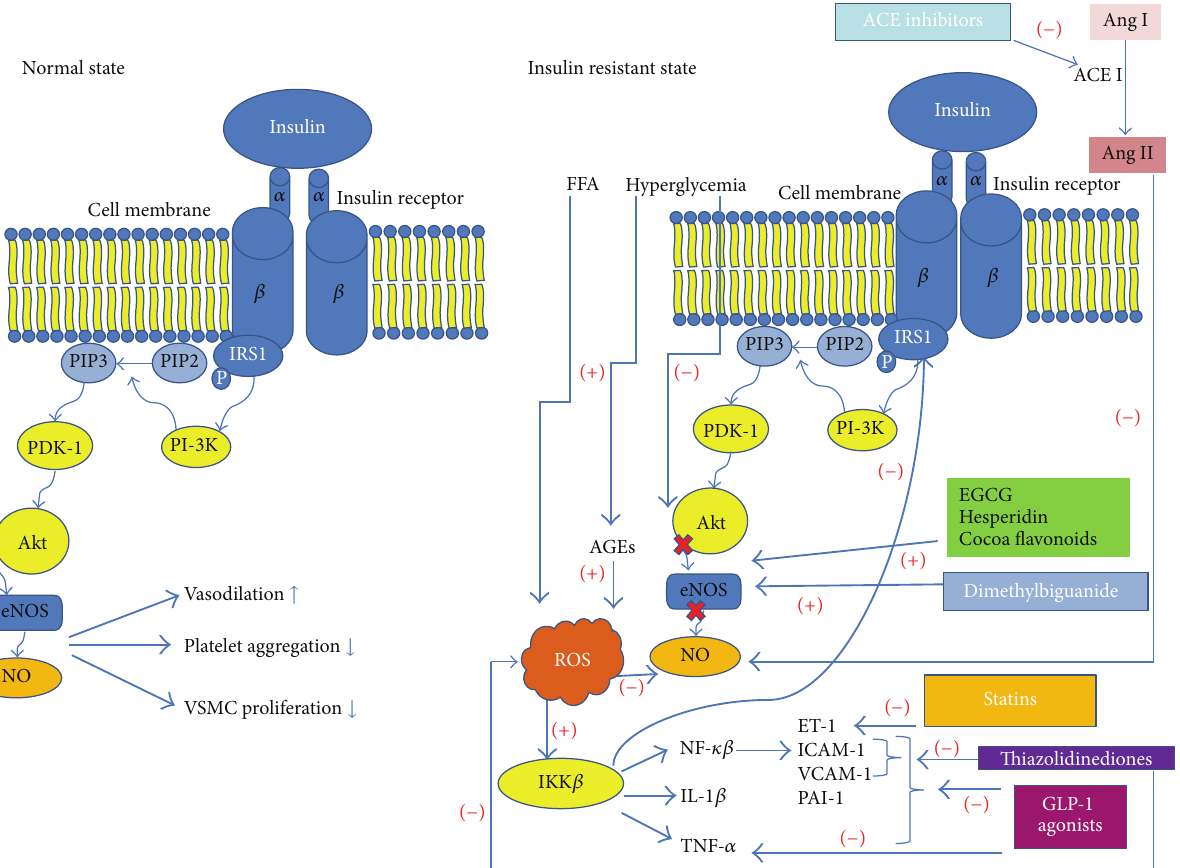
Figure 3: Changes in expression of particular molecular pathways in insulin resistant state versus under physiological condition. Molecular definition of drug targets for management of insulin resistance. 𝛼 : alfa subunit of insulin receptor; 𝛽 : beta subunit of insulin receptor; Shc: Src homology and collagen protein; Grb2: cytosolic growth factor receptor-bound protein 2; IRS1: insulin receptor substrate; SOS: proline- rich domain of the son of sevenless; Ras: family of related proteins; Raf: serine/threonine specific protein kinases; MEK1/2: mitogen-activated proteinkinase;ERK/MAPK:mitogen-activatedproteinkinase;ET-1:endothelin-1;GLP-1:glucagon-likepeptide;PAI-1:plasminogenactivator inhibitor; ICAM-1: intercellular adhesion molecule 1; VCAM-1: vascular cell adhesion molecule 1; Ang I: angiotensin I; Ang II: angiotensin II; ACE I: angiotensin converting enzyme I; TNF-alpha: tumour necrosis factor alpha; ROS: reactive oxygen species; Akt: the Akt kinase; eNOS: endothelial nitric oxide synthase; AGEs: advanced glycation end